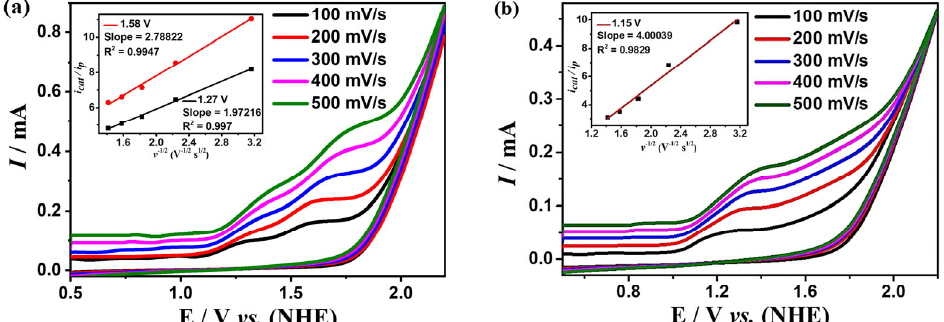
Figure 5. Cyclic voltammogram of 0.5 mM complexes 1 ( a ) and 2 ( b ) in DMF:H 2 O (3:7 v / v ) solution containing 0.2 M phosphonate buffer, the sweep speed range is 100–500 mV s − 1 . The inset is the relationships of the values of i cat / i p with the inverse function of square root of sweep velocity.